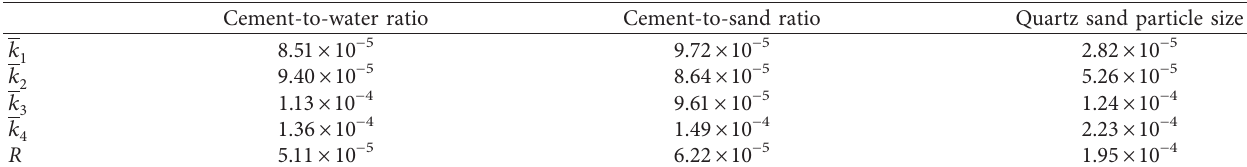
Table 3: Range analysis of permeability